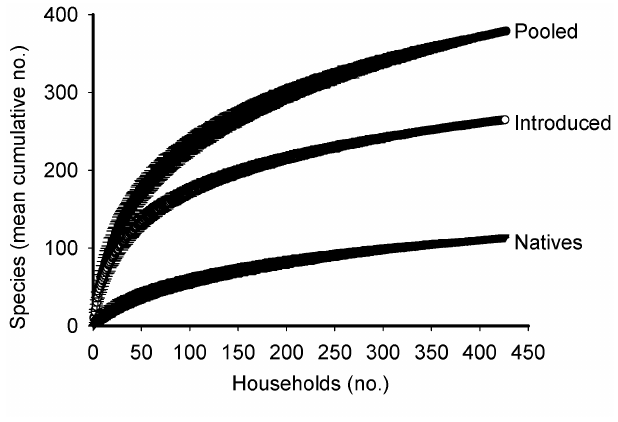
Fig. 6 . Species accumulation curves based on data for 424 households across the Río Piedras watershed, based on origin (native and non-native).